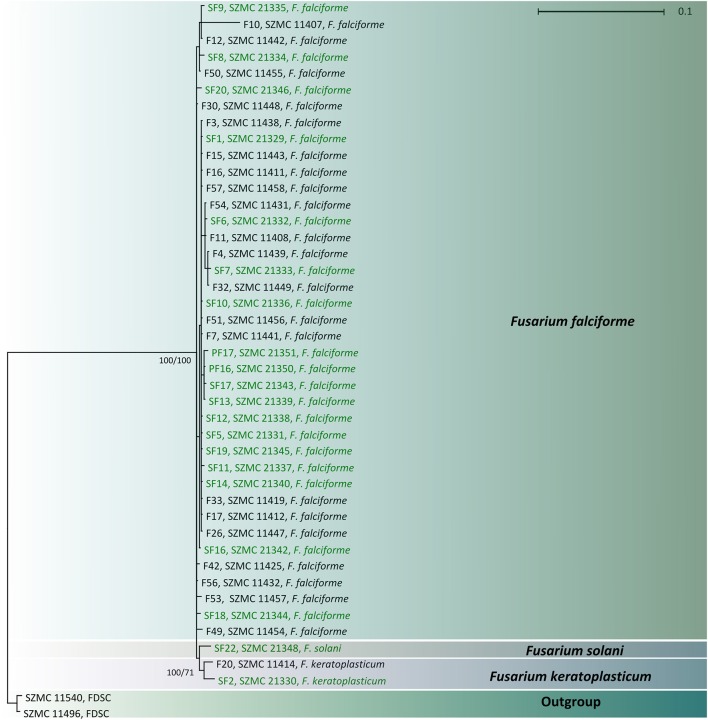
Combined phylogenetic tree based on the partial sequences of translation elongation factor 1α genes of clinical (indicated with black letters) and environmental (indicated with green letters) FSSC isolates. Only Bayesian posterior probability and ML bootstrap support values >0.95 and 60% are shown at the nodes.